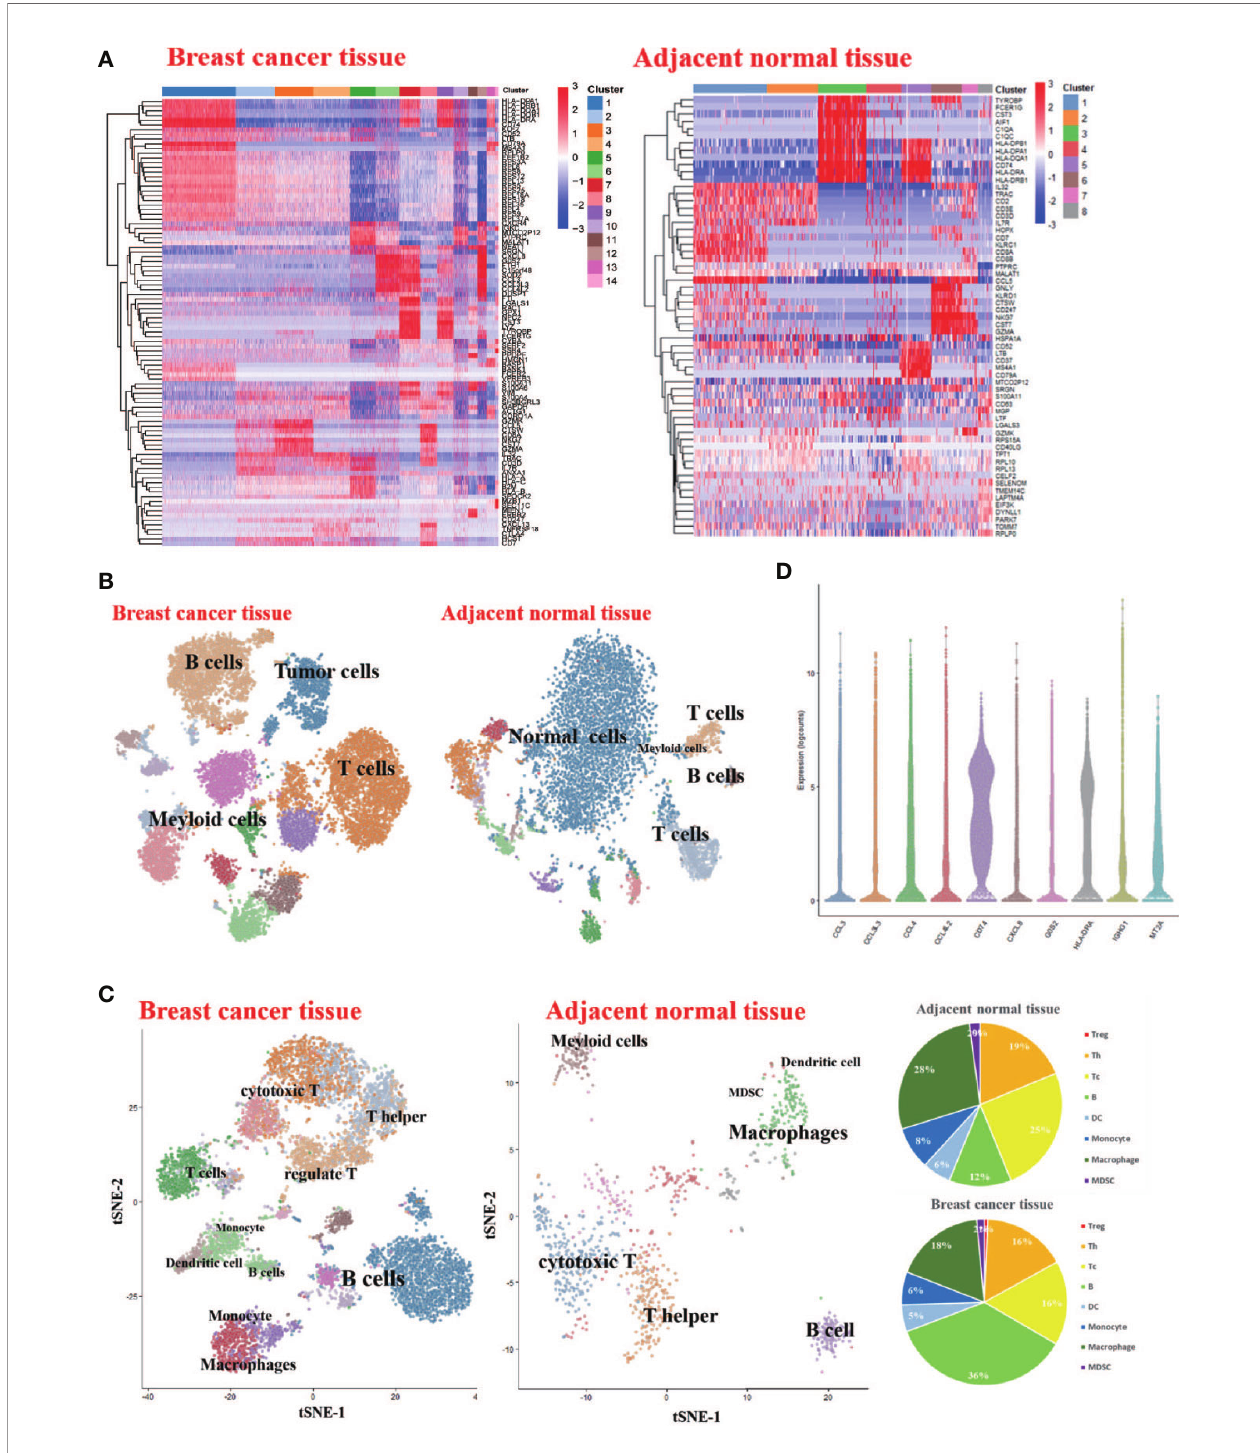
FIGURE 1 | Single-Cell RNA-Seq Experimental Initial Data Exploration (A) Heatmap of log counts of genes in signature. (B) t-SNE of complete cells isolated from the breast cancer tissue and matched adjacent normal breast tissue. (C) t-SNE of CD45+ cells isolated from the breast cancer tissue and matched normal breast tissue (Left). Pie charts of cell-type fractions for the patient ’ s tumor-in fi ltrating immune cells, colored by cell type (Right). (D) The violin plot shows the top 10 most variable genes among different cells in the breast cancer